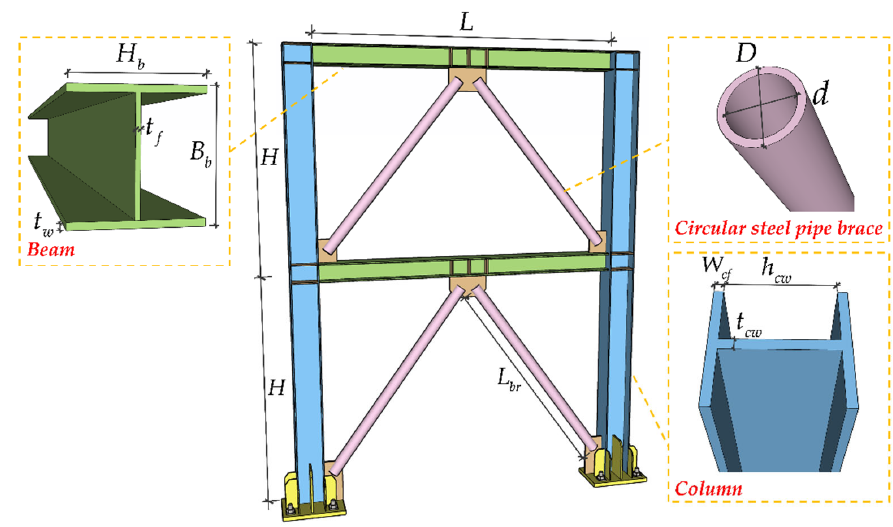
Figure 1. The components of a steel concentrically ‐ braced frame.